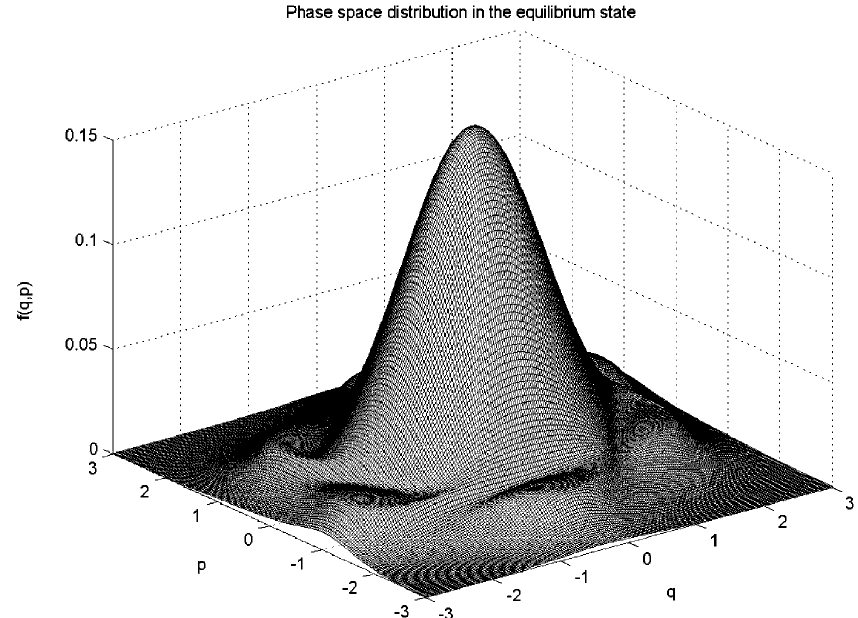
FIG. 6. 3D plot of f (cid:1) q; p (cid:2) in the equilibrium